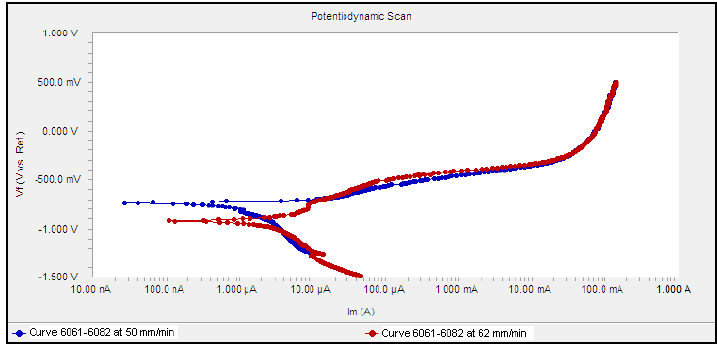
Figure 13: Polarization curves of AA6061-AA6082 at 50-62